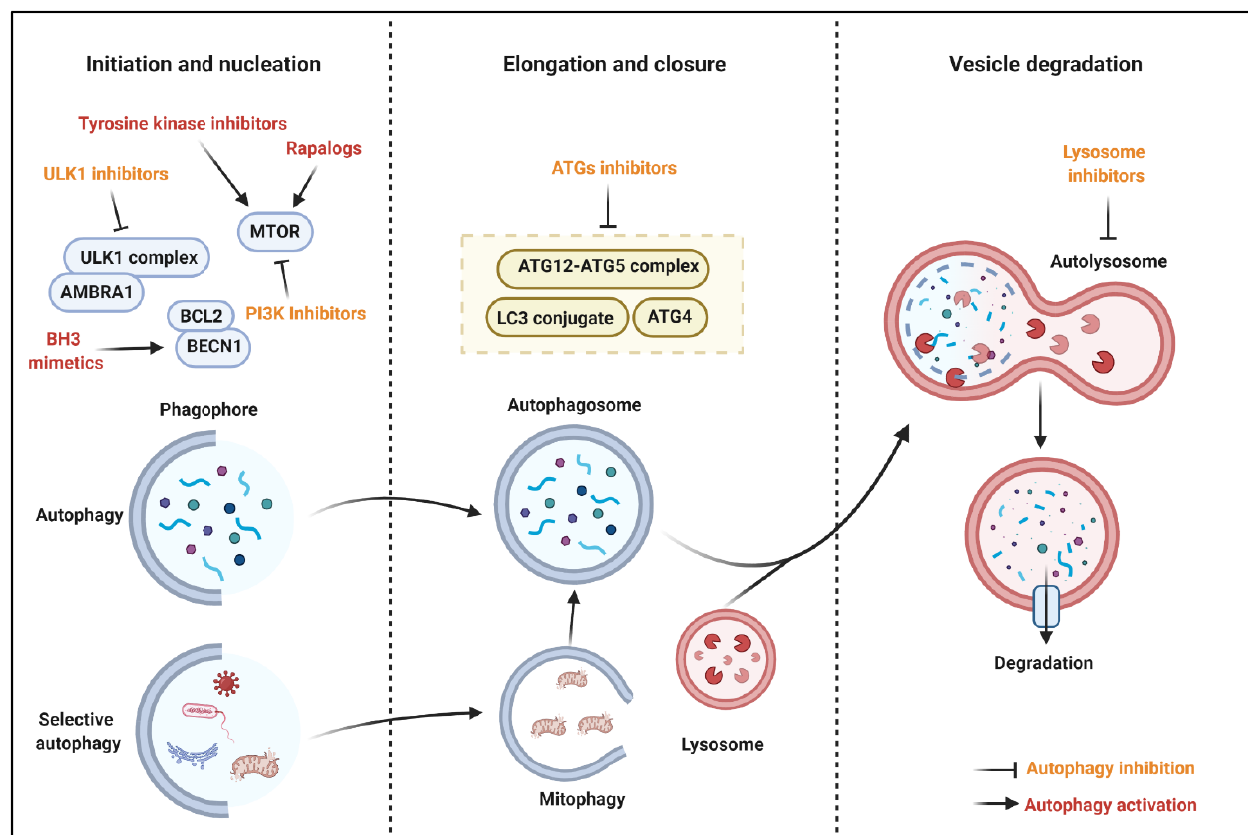
Figure 3. Autophagic modulation for cancer. Autophagy represents a promising opportunity for cancer therapy. Considering the dual role of autophagy during the different phases of cancer, it is not surprising that both activators and inhibitors are feasible anti-cancer compounds. Tyrosine kinase inhibitors (such as sorafenib), rapalogs (everolimus and temsirolimus), and BH3 mimetics (such as obatoclax and sabutoclax) activate autophagy during the early phase. Opposingly, ULK1 (such as SBI-0206965, ULK-1001, and MRT67307) and PI3K inhibitors (such as wortmannin and 3-methyladenine) interfere with this autophagy phase. ATG inhibitors (like NSC185058) block autophagy by preventing the elongation and closure of the autophagic vesicle. Finally, lysosome inhibitors (like chloroquine and derivatives) avoid the fusion of the lysosome with autophagosome or block the activity of lysosomal hydrolases.